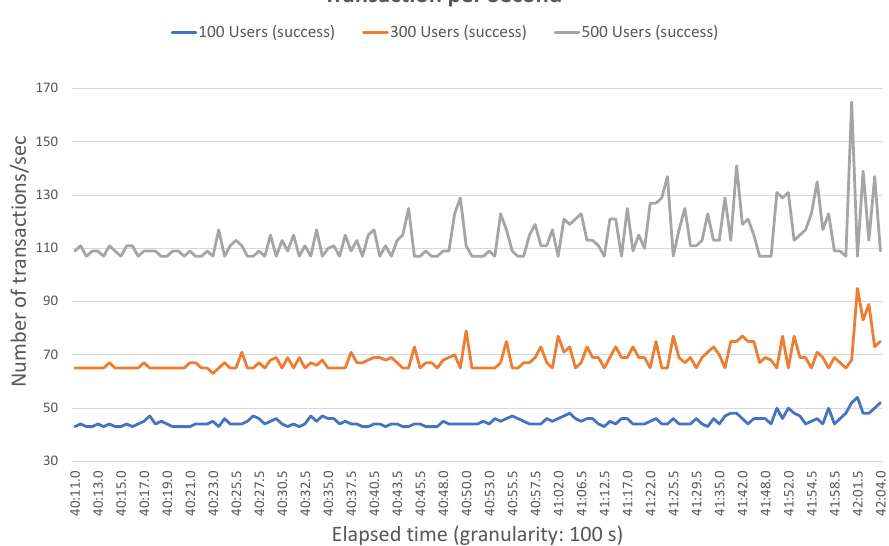
Figure 27. Transaction per second at different simultaneous request.